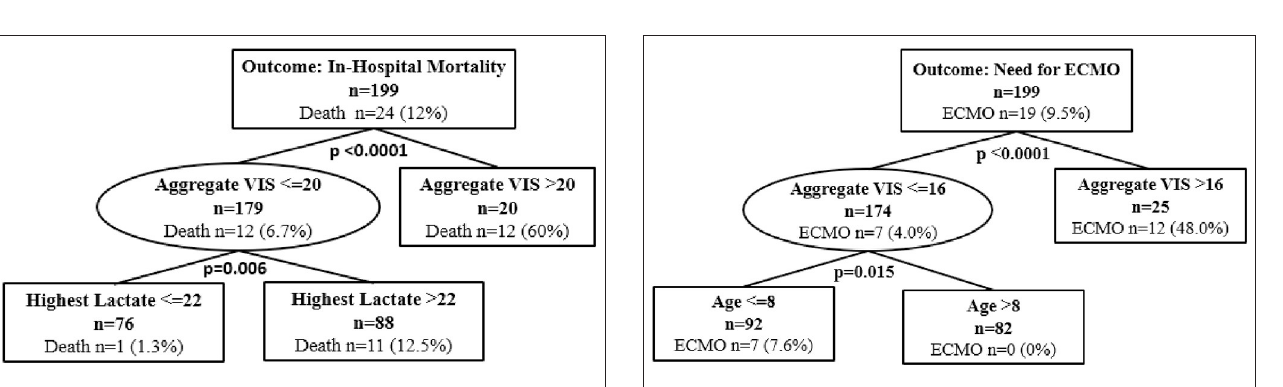
FIGURE 3 | Classification and regression tree (CART) analysis for need for ECMO cannulation. N = 199. ECMO, Extracorporeal Membrane